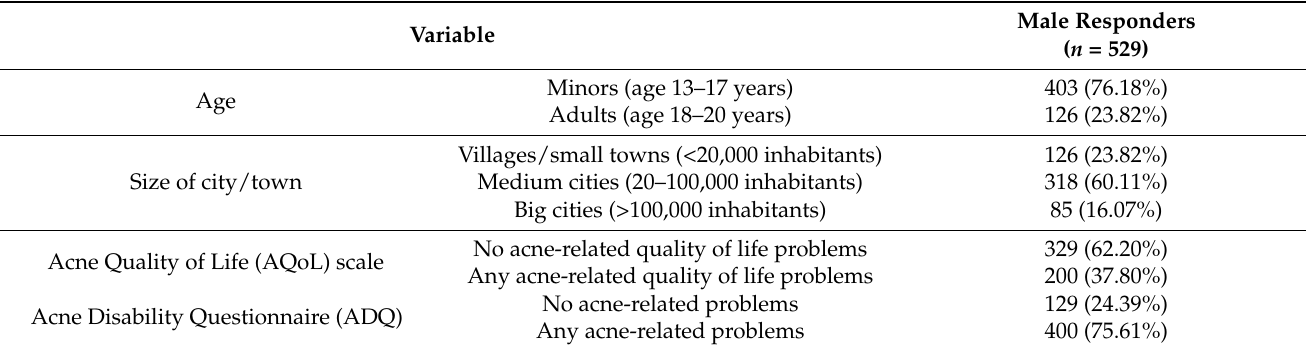
Table 1. The baseline characteristics of the studied group of male adolescent participants of the study.